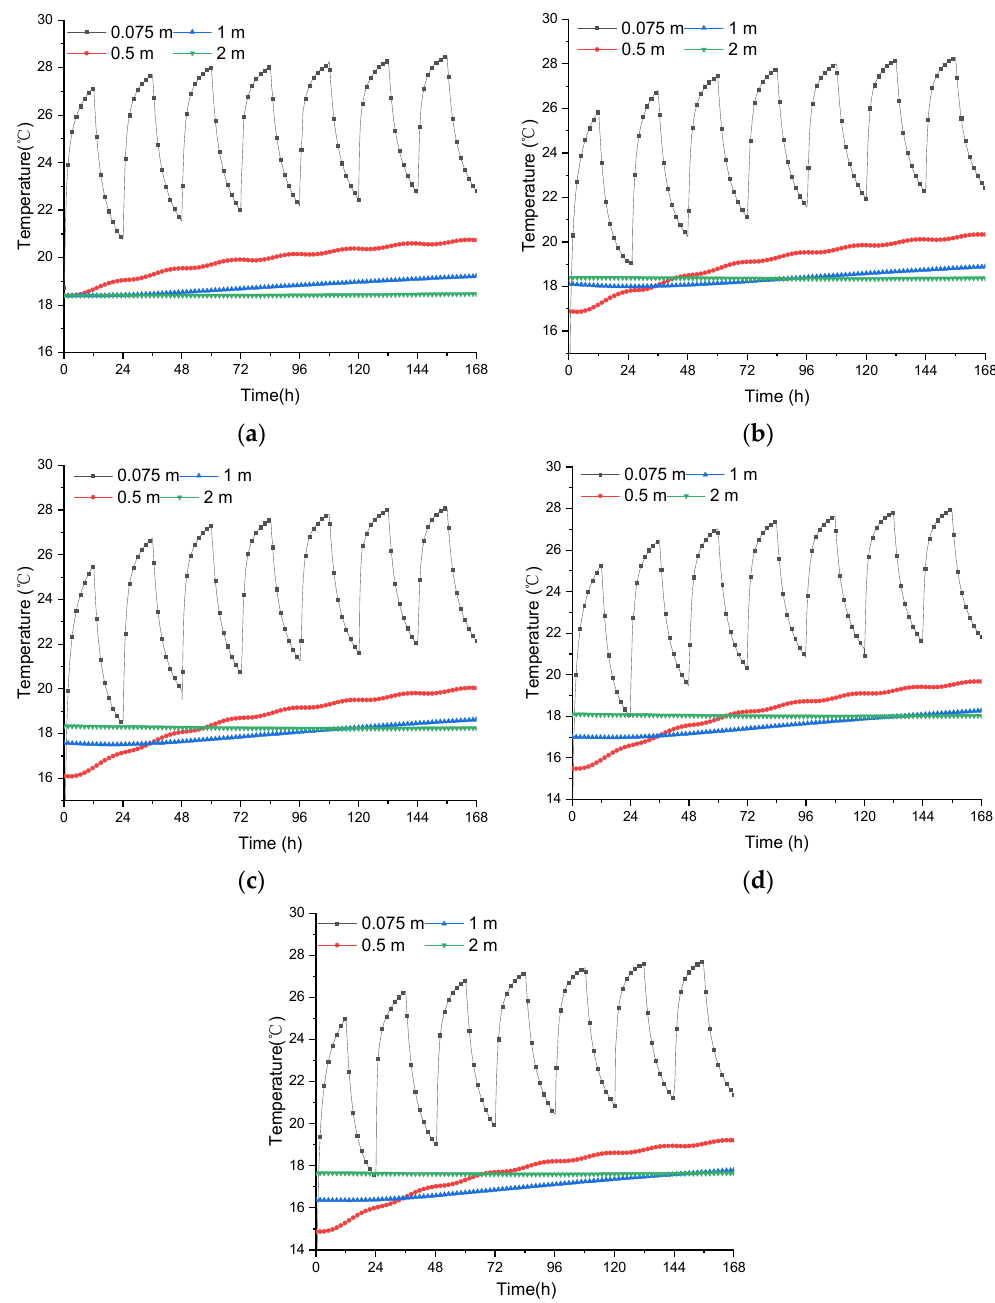
Figure 4. Dynamic temperature response at the borehole wall (r = 0.075 m) and in the soil at radial distances of 0.5, 1, and 2 m from the borehole axis under different precooling times. ( a ) Without precooling (Case 1); ( b ) With precooling 3 d (Case 2); ( c ) With precooling 7 d (Case 3); ( d ) With precooling 14 d (Case 4); ( e ) With precooling 30 d (Case 5). The excess temperature θ represents the soil temperature differences between a certain time and initial time for each monitoring point in the soil. Equation (1) for this calculation is as follows: where T s ( t ) is the temperature of the soil at a certain time, ◦ C, and T 0 is the initial temperature of the soil, 18.4 °C.